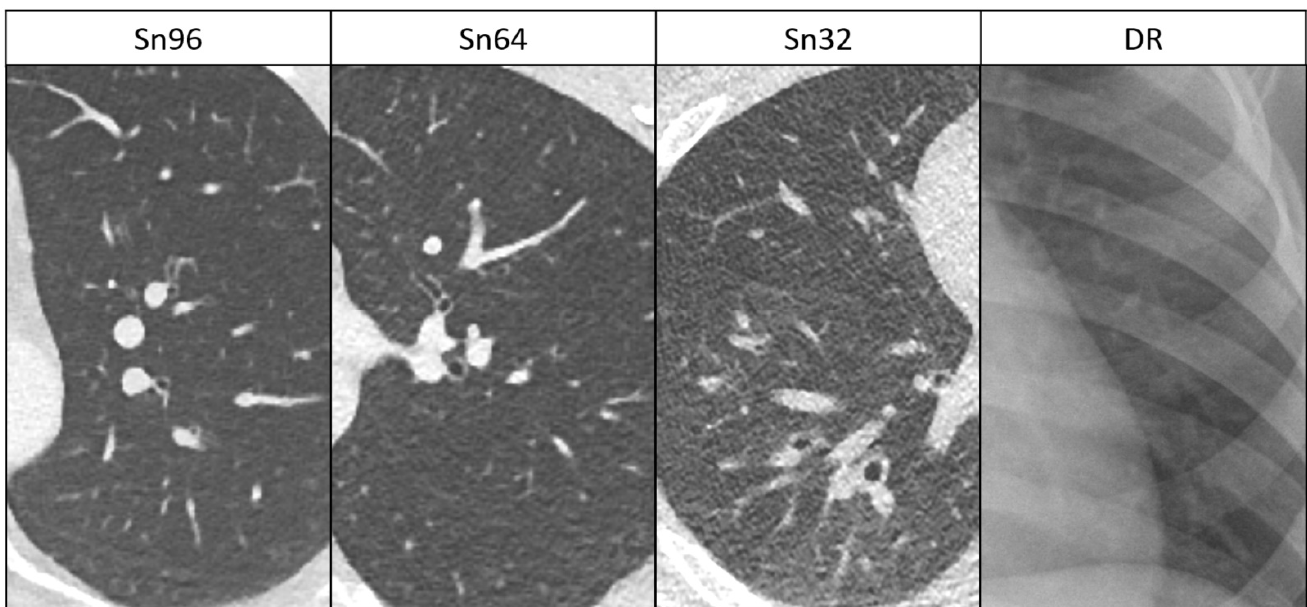
Figure 1. Delineation of anatomical structures in low-dose DSCT (ADMIRE 4) and DR. Sn96: 18-year-old boy, Sn64: 17-year-old girl, Sn32: 14-year-old boy and DR: 11-year-old boy. Delineation of anatomical structures such as bronchial walls is acceptable in the Sn96 and Sn64 groups and partially limited in the Sn32 group, but it is always superior compared to DR.